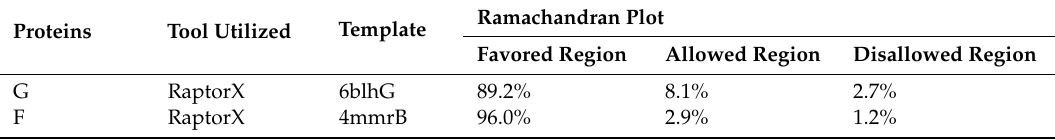
Table 1. Structural details of the respiratory syncytial virus (RSV) proteins predicted